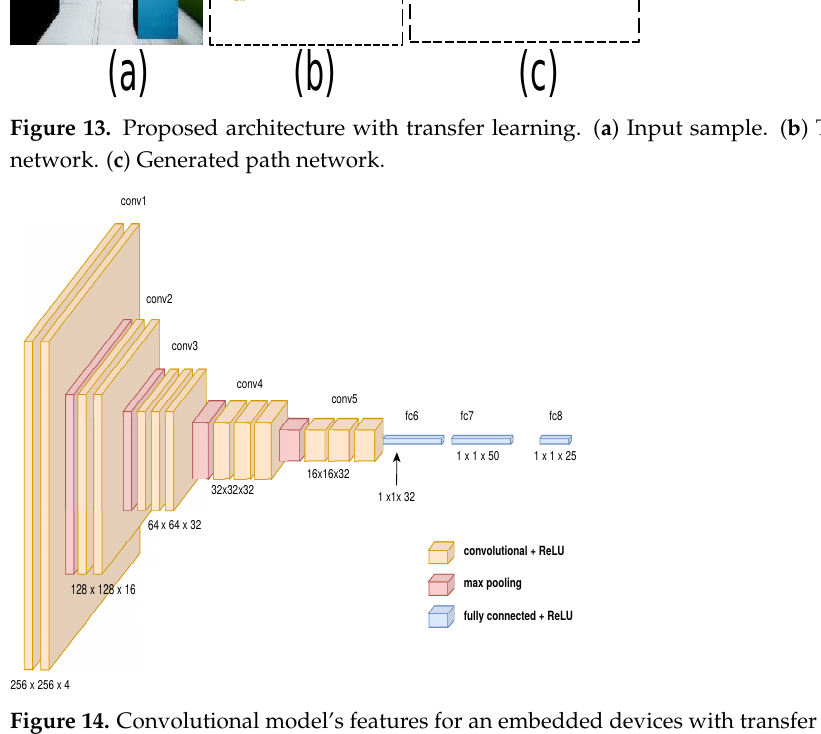
Figure 14. Convolutional model’s features for an embedded devices with transfer